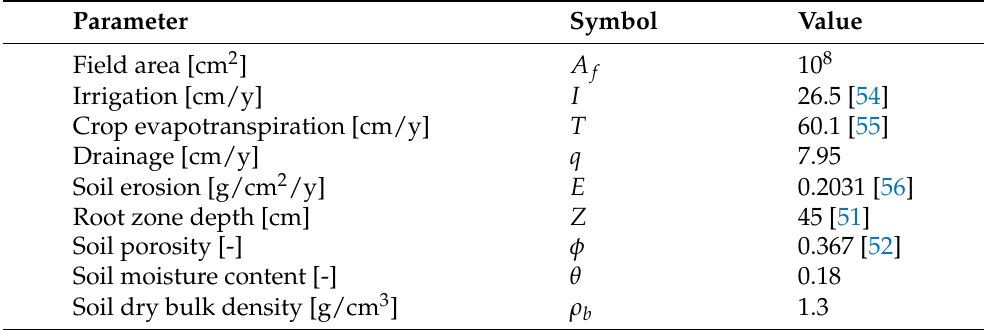
Table 1. Average annual water and sediment fluxes and soil parameters typical of the study